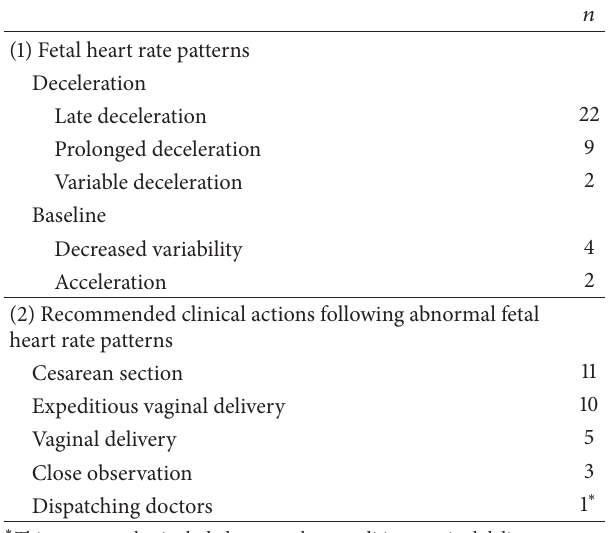
Table 4: The fetal heart rate patterns on inquiry during 8 months in period 2 ( 𝑛 = 28